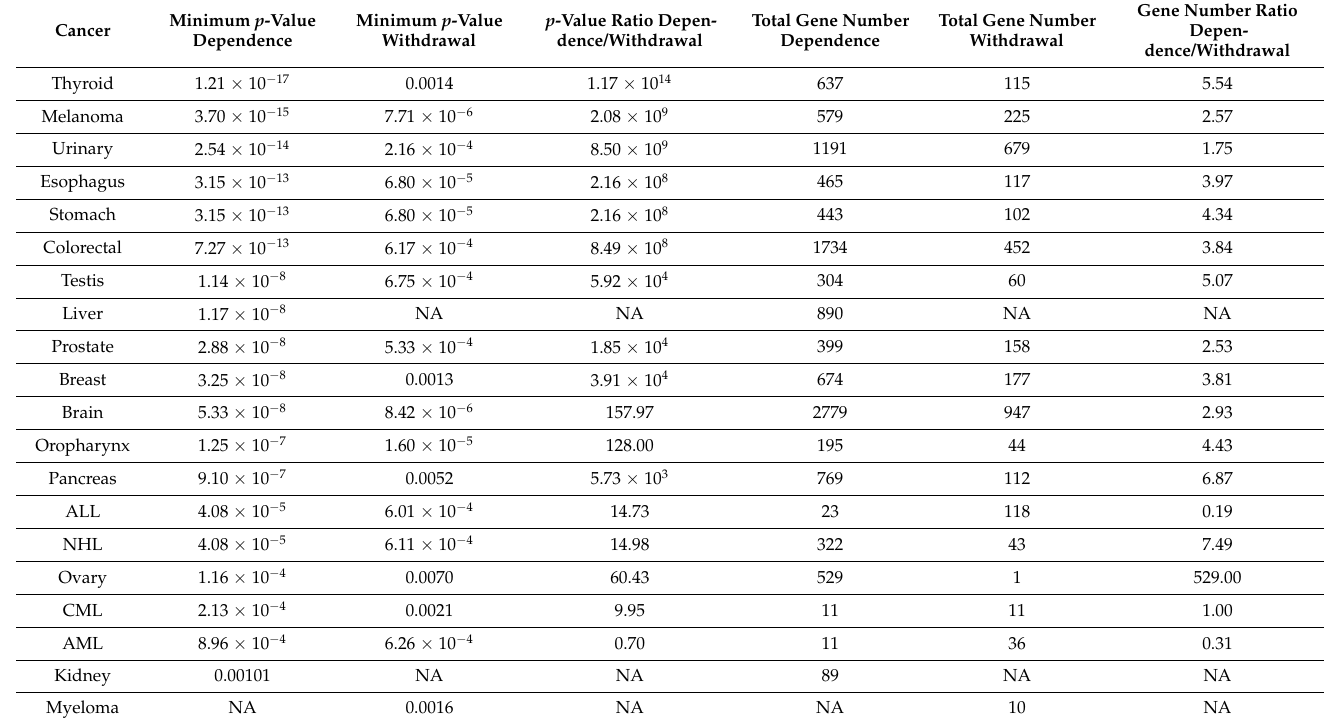
Table 11. Contrast of Cannabis Dependence and Withdrawal Significance Levels and Gene Numbers, Schrott